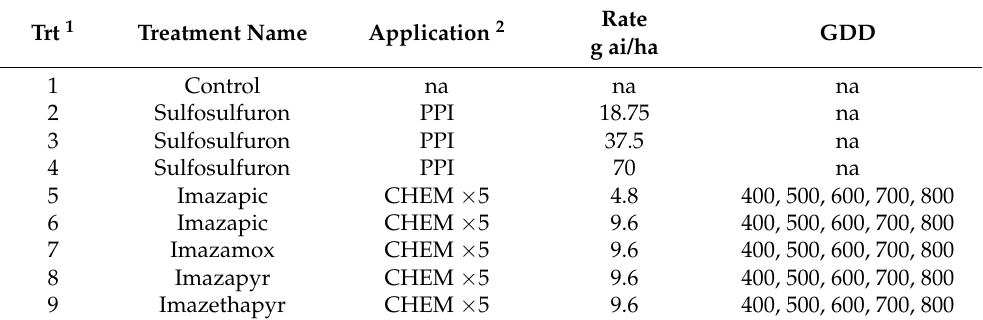
Table 8. 2019 and 2020 herbicide treatments applied to a tomato crop in a rotational crop safety